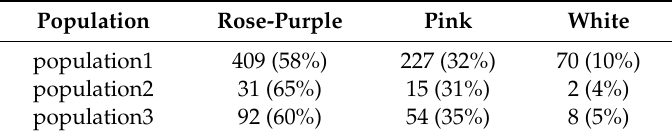
Table 1. Number of P. limprichtii individuals of each flower color polymorph in three selected populations at the opening stage.